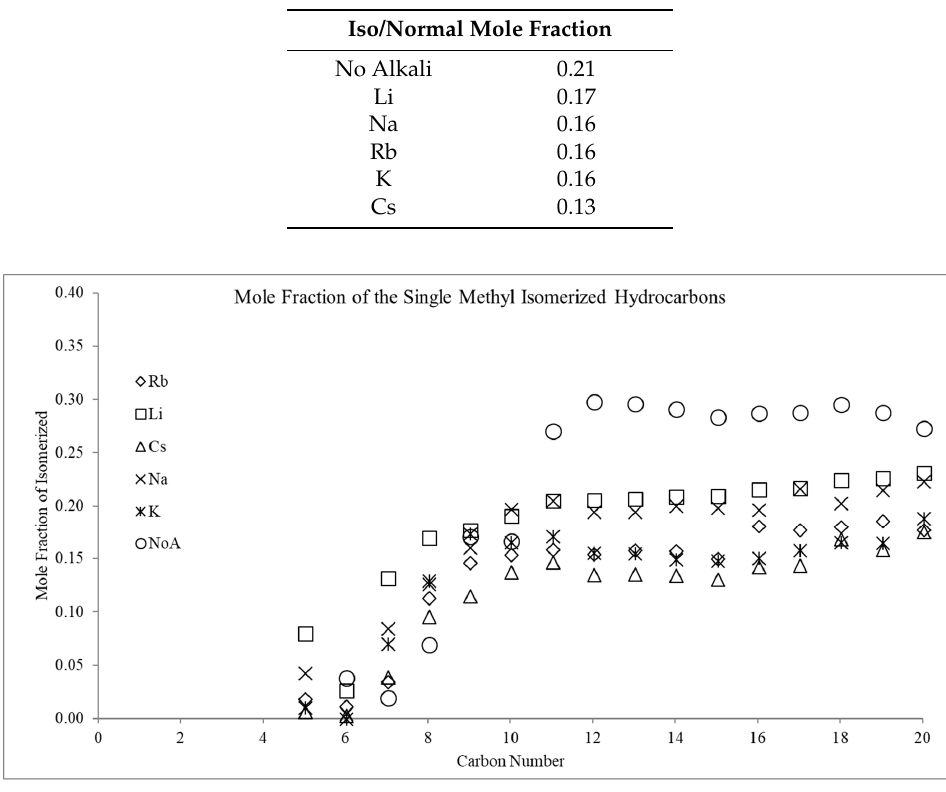
Figure 47. The molar carbon fraction of the total isomerized hydrocarbons per carbon number for the Group I series iron catalysts. As the basicity of the metal increases, allowing for more back donation, the overall branched material decreases. Reactor Conditions: 230 °C, 12.1 bar, WHSV = 2, and H 2 /CO = 0.7. Catalysts 201 9 , 8 , x FOR PEER REVIEW